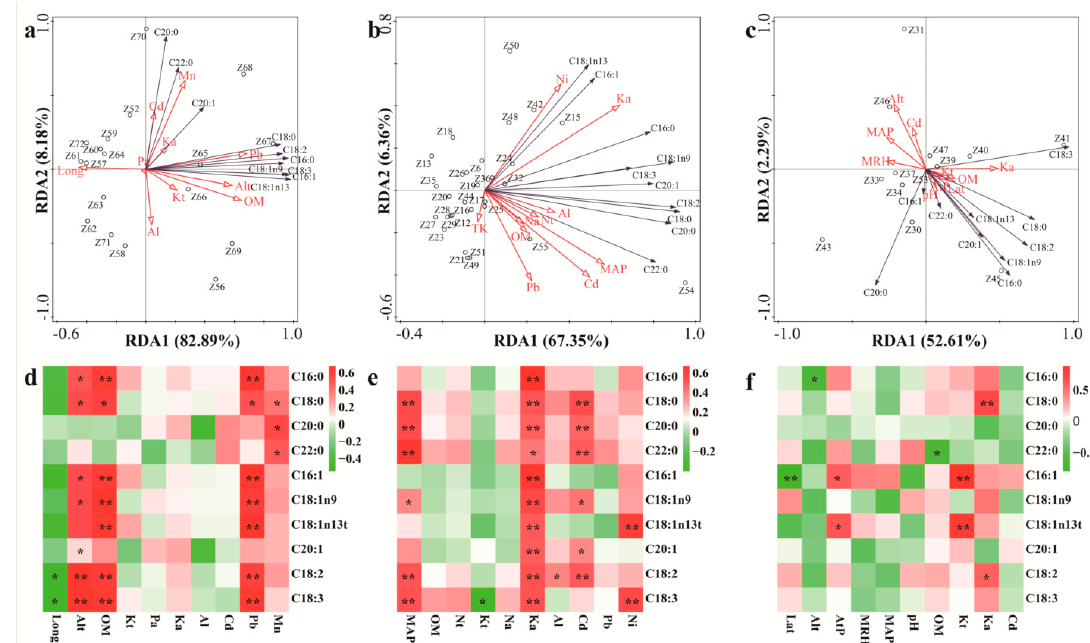
Figure 5. The relationships between environmental factors and pericarp fatty acid composition for di ff erent Zanthoxylum species: ( a ), the relationship between environmental factors and pericarp fatty acid composition for ZA; ( b ), the relationship between environmental factors and pericarp fatty acid composition for ZB1; ( c ), the relationship between environmental factors and pericarp fatty acid composition for ZB2; ( d ), the correlation between environmental factors and pericarp fatty acid composition for ZA; ( e ), the correlation between environmental factors and pericarp fatty acid composition for ZB1; ( f ), the correlation between environmental factors and pericarp fatty acid composition for ZB2. RDA is redundancy analyses; Long is longitude; Alt, altitude; AtP, atmospheric pressure; MT, mean temperature; MAP, mean annual precipitation; pH, power of hydrogen; OM, organic matter content in soil; Pt, total phosphorus content in soil; Kt, total potassium content in soil; Pa, available phosphorus content in soil; Ka, available potassium content in soil; Al, aluminium content in soil; Cd, cadmium content in soil; Pb, lead content in soil; Mn, manganese content in soil; C16:0, palmitic acid; C18:0, stearic acid; C20:0, eicosanoic acid; C22:0, behenic acid; C16:1, palmitoleic acid; C18:1n9, oleic acid; C18:1n13t, trans-13-oleic acid; C20:1, cis-11-eicosenoic acid; C18:2, linoleic acid; C18:3, and linolenic acid; * represents medium correlation (0.4–0.6); ** represents strong correlation (0.6–0.8).